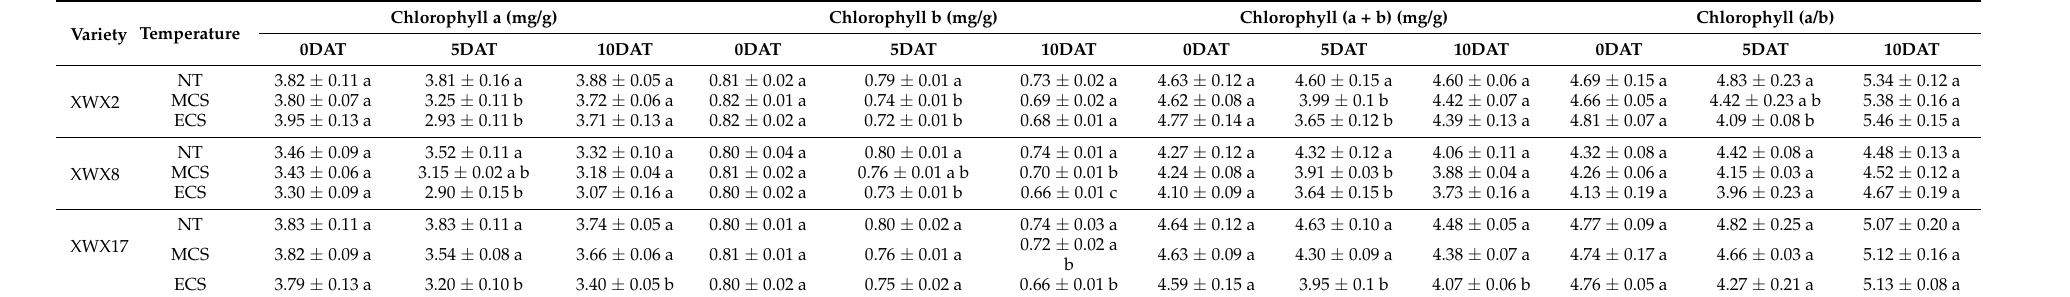
Note: The data were presented as mean value ± standard error (SE) of three replicates. Different lowercase letters denote statistical differences between temperature treatments of a variety at the 5% level according to LSD test. XWX2: Xiangwanxian2; XWX8: Xiangwanxian8; XWX17: Xiangwanxian17; NT: Normal temperature control; MCS: Moderate chilling stress; ECS: Extreme chilling